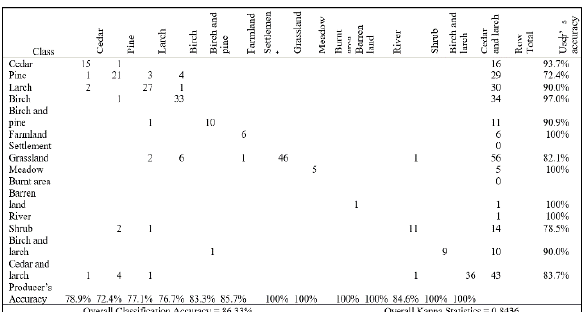
Table 3. Error matrix for the overall classification in 2000